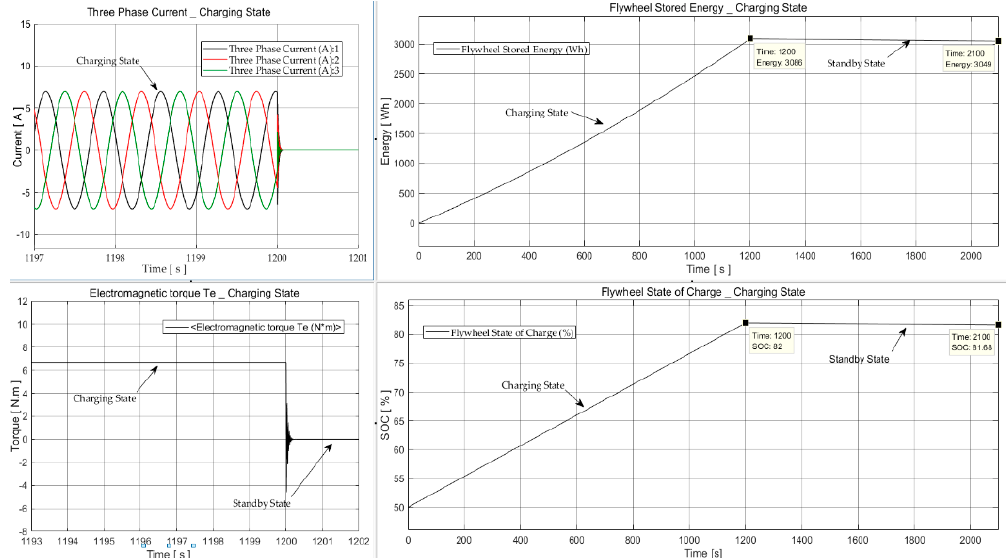
Figure 11. FESS in charging mode: Three-phase current (top left); Flywheel stored energy (top right); Electromagnetic torque (bottom left); Flywheel SOC (bottom right).